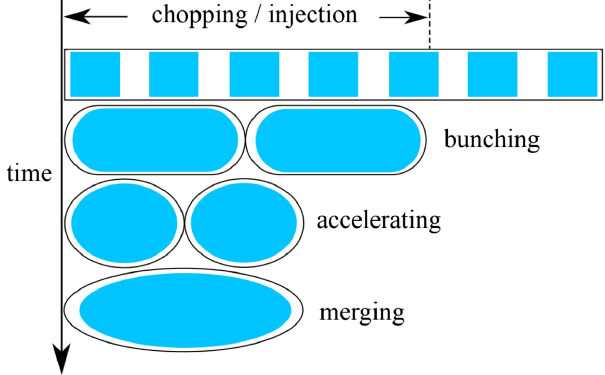
FIG. 1. Proposed scheme of the longitudinal proton beam manipulations in one beam cycle for the upcoming CSNS-II. The injected beams are bunched into two buckets with the initial ¼ 2 . Afterward, the two bunches are harmonic number h i accelerated via increasing rf voltage. Finally, the two bunches are merged into one single bunch before extraction under the dual ¼ 2 and the final harmonic rf system with the initial harmonic h i ¼ 1 h f